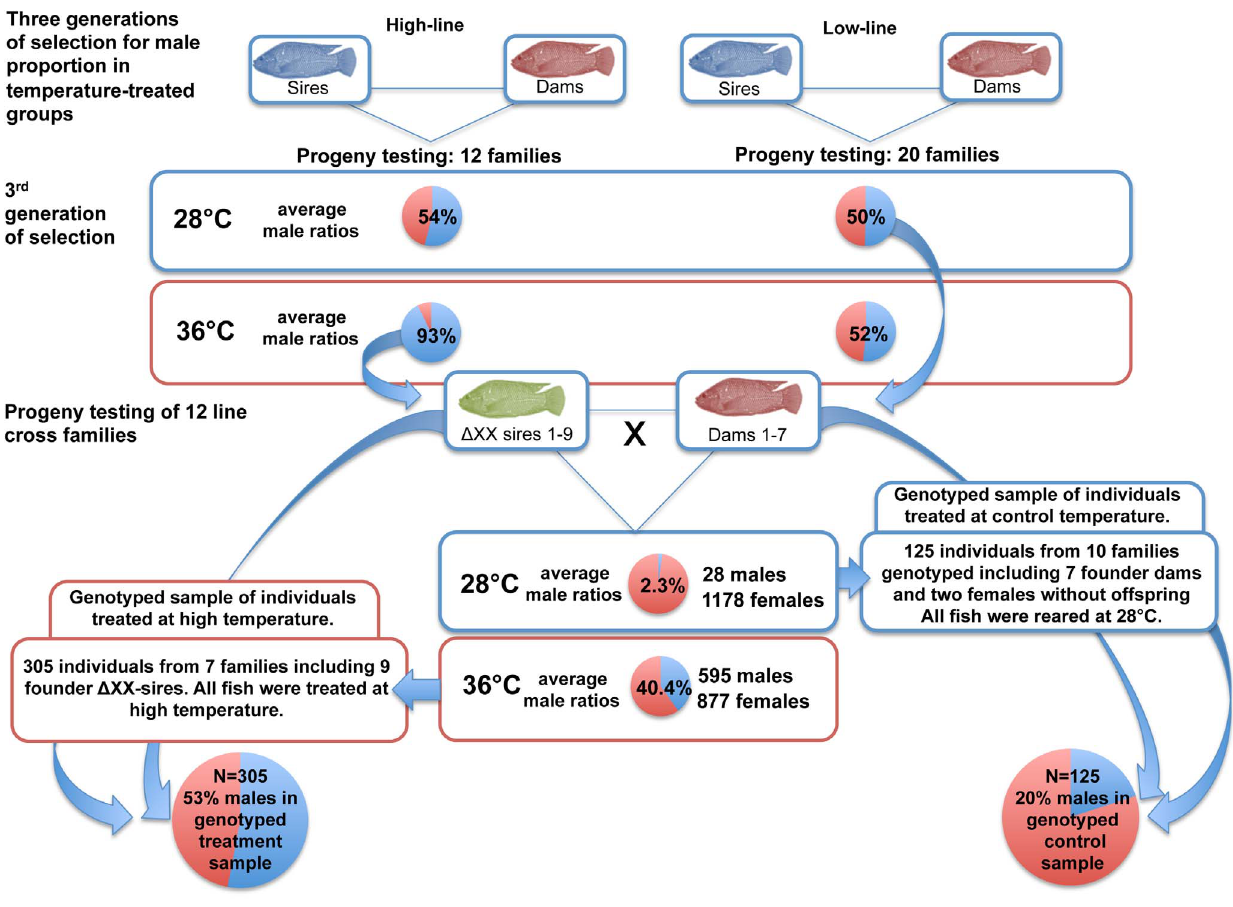
Figure 1. Experimental design to obtain a genetically female (XX) population in order to study temperature effects on the male proportion in a selected line of Nile tilapia.